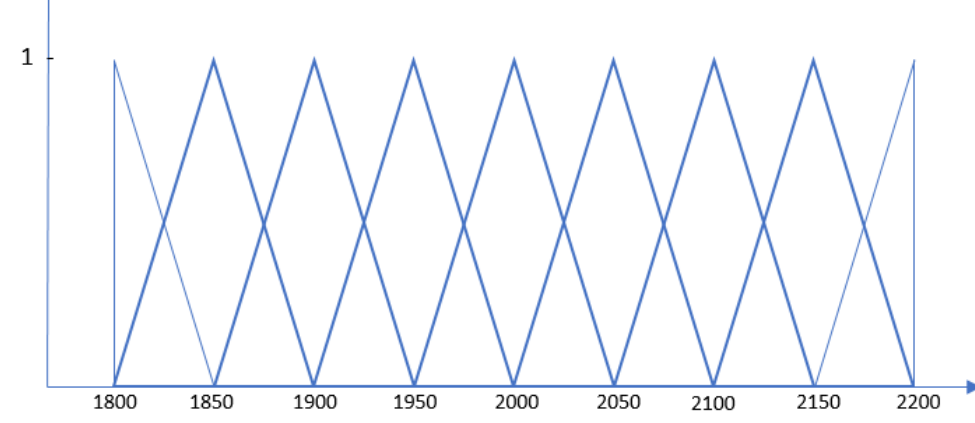
8 of 16 Figure 3. The time-series plot of the Stock and Price (S&P) dataset.